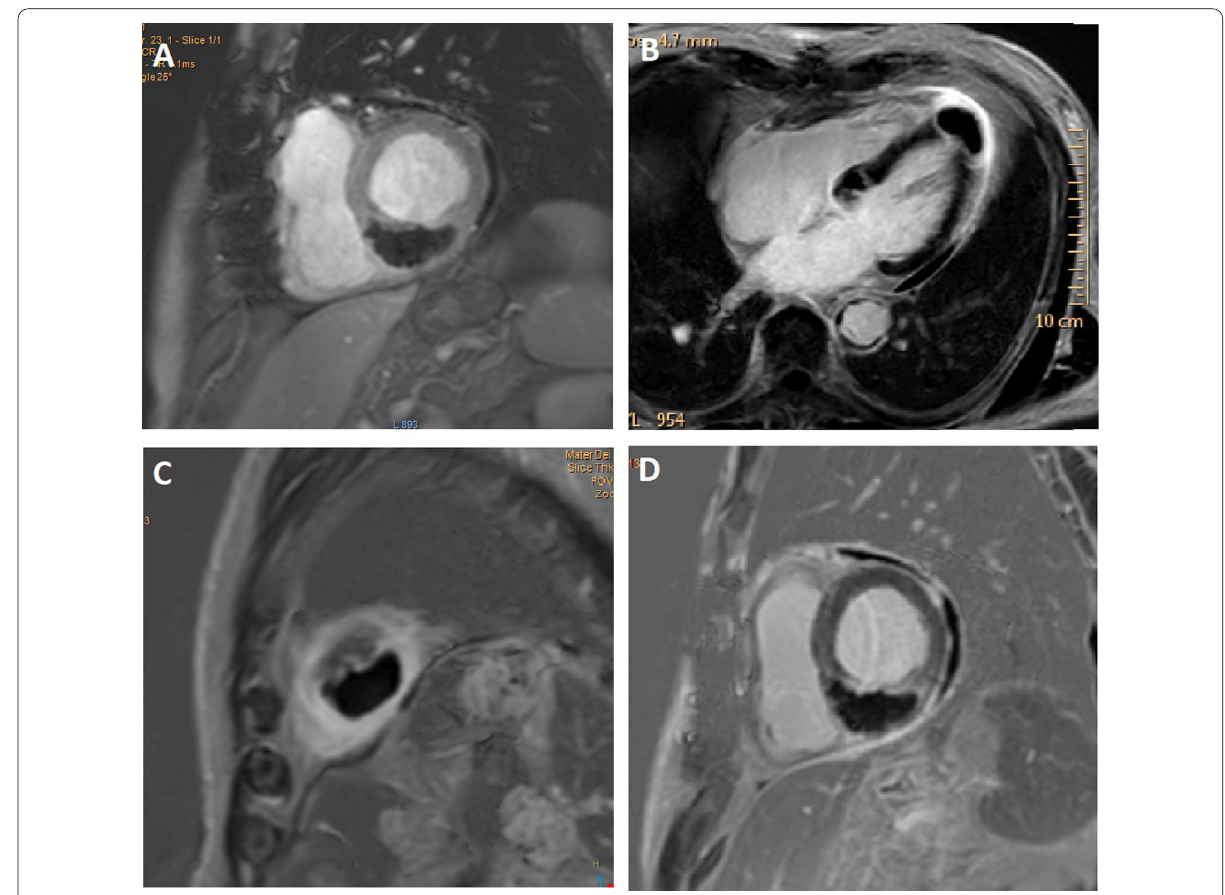
Fig. 4 Cardiac Magnetic Resonance Imaging: A Early Gadolinium enhancement in short axis view. Late Gadolinium enhancement CMR images in 4-chamber view ( B ) and short axis views ( C , D ) revealing two lesions at base of LV apex and base of interventricular septum. Lesions demonstrate no gadolinium enhancement indicating avascular